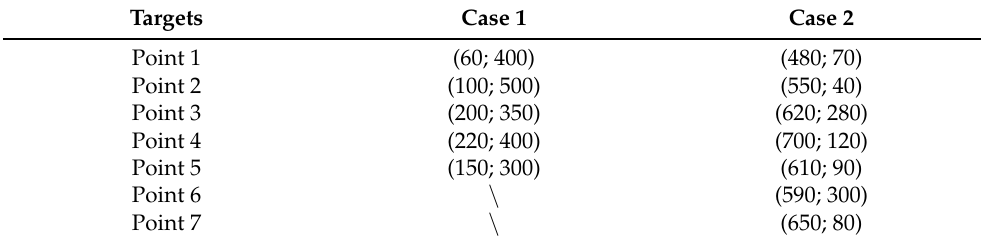
Table 1. Distribution of